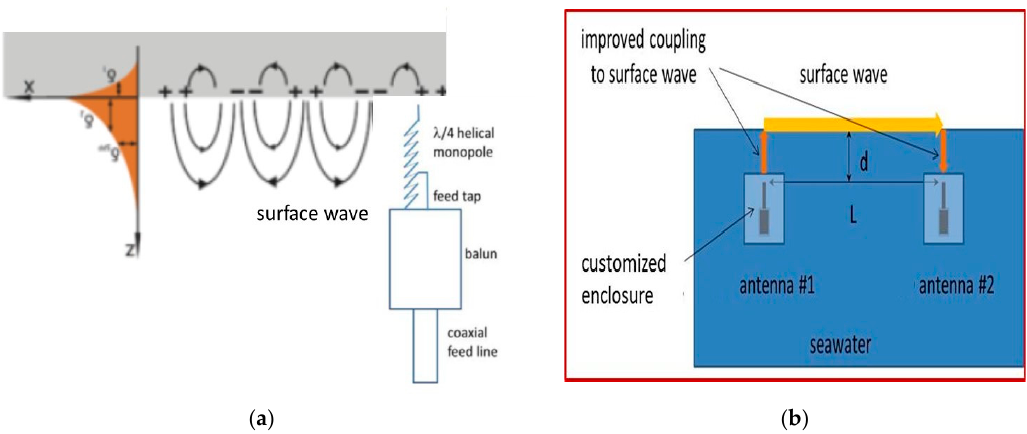
Figure 1. Operation of the SEW antenna near a conductor/dielectric interface where the antenna is placed either on the dielectric (air) side of the interface, or on the conductor (seawater) side near the interface: ( a ) Schematic geometry of a 2.4 GHz surface wave antenna design based on helical monopole shorted to its feed line outer conductor. The tip of the antenna is shown near a flat conductive surface where it excites an omnidirectional surface electromagnetic wave. The electromagnetic field of the surface electromagnetic wave is partially longitudinal, which means that an efficient surface wave antenna needs a strong field enhancement at its apex, which “pushes” charges along the metal surface; ( b ) Principle of operation of a similar underwater surface electromagnetic wave RF transmitter.